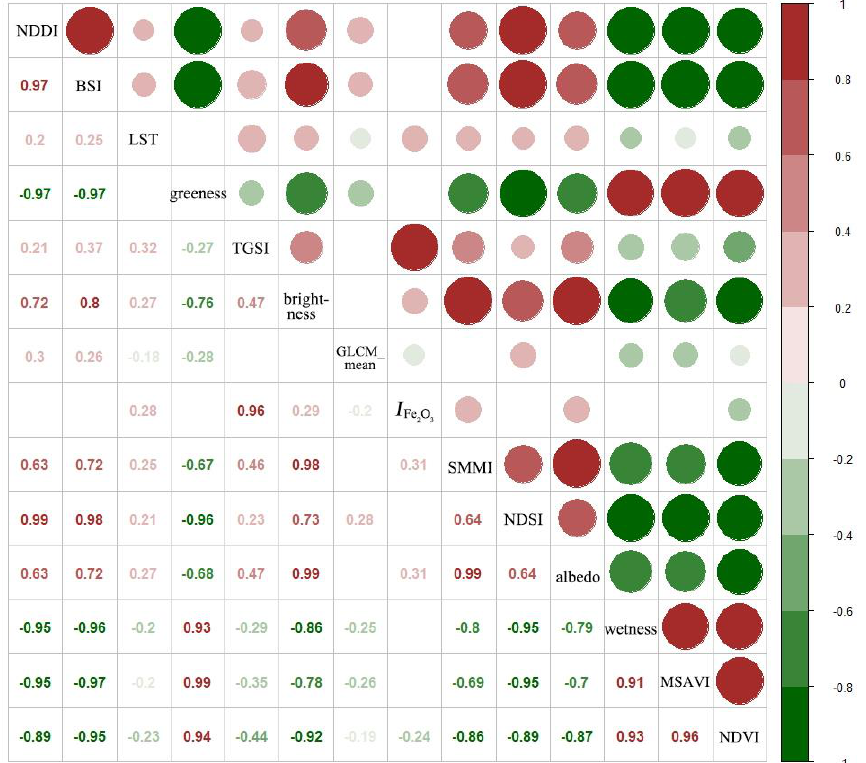
Figure A4. Correlation coefficients of the desertification index. The blank grid indicates that the p -value in the correlation analysis of the two indicators is greater than 0.05.